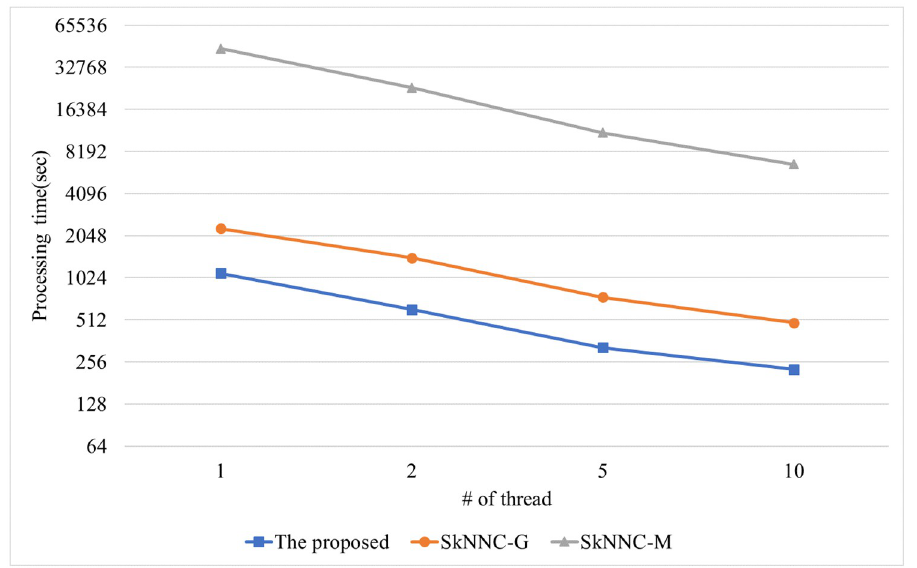
Fig 15. Processing time with varying the number of